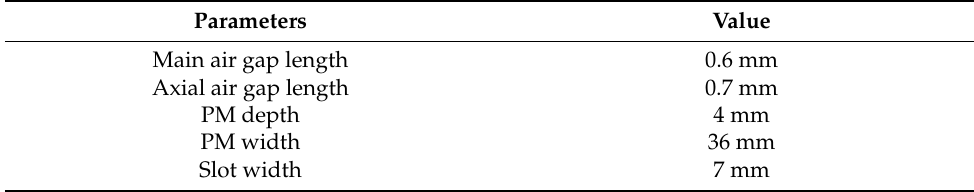
Table 2. Optimized generator parameters.